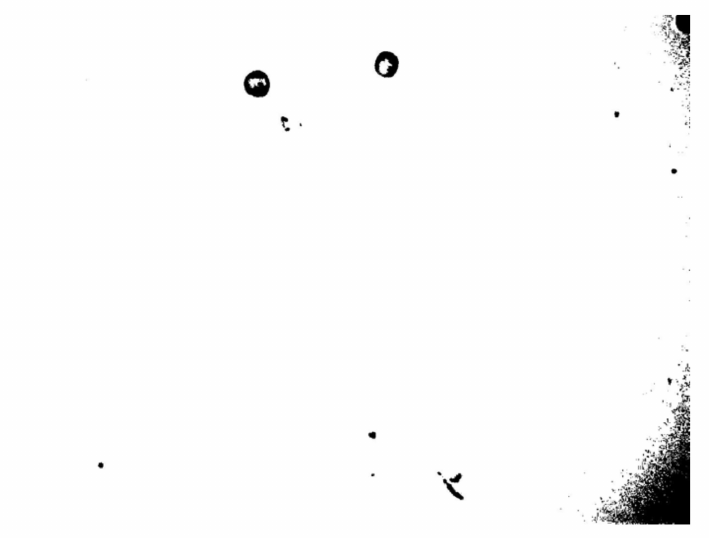
Figure 3. Binarization of cell images without removing the dark